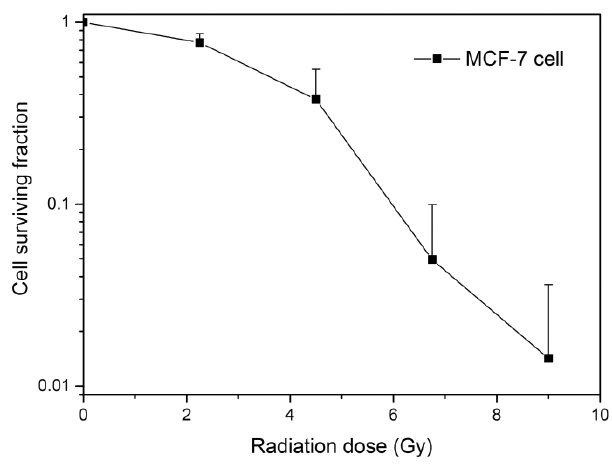
Fig. 2. Radiotherapy e®ect of MCF-7 cells.